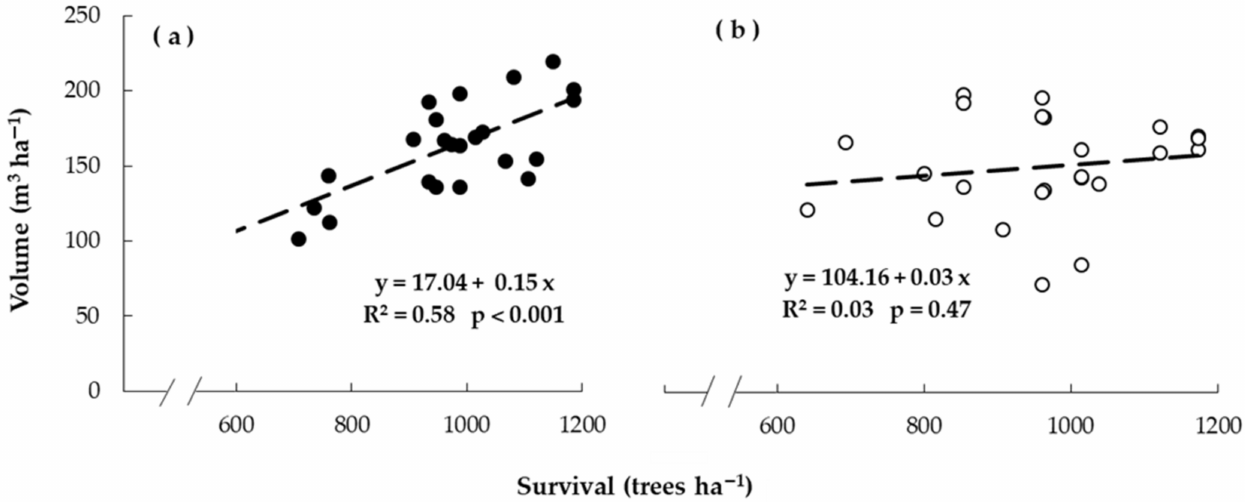
Figure 7. Volume of Eucalyptus pellita at age 6 years: relationship between tree survival and stem volume: ( a ) with P fertilizer (pooled-data of added P treatments), ( b ) without P fertilizer. Data points represent individual plots from all replications and respective treatments from six sites.